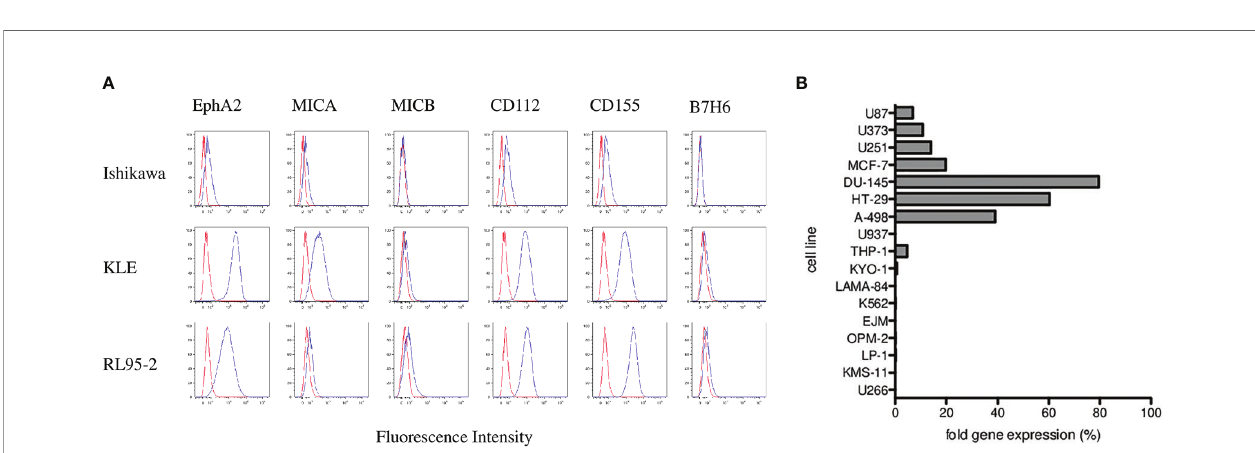
FIGURE 5 | Phenotyping and surface expression of EphA2, MICA, MICB, CD112, CD155, and B7-H6 on target endometrial tumor cell lines including Ishikawa, KLE, and RL95-2 by fl ow cytometry. (A) Representative plots are shown as histograms of the unstained controls (red) and histograms representing the stained samples (blue). Data are expressed as mean fl uorescence intensity (MFI, x -axis) versus number of cells ( y -axis). (B) Summary of the EphA2 expression analyzed by the real-time qPCR in a panel of tumor cell lines presented as fold gene